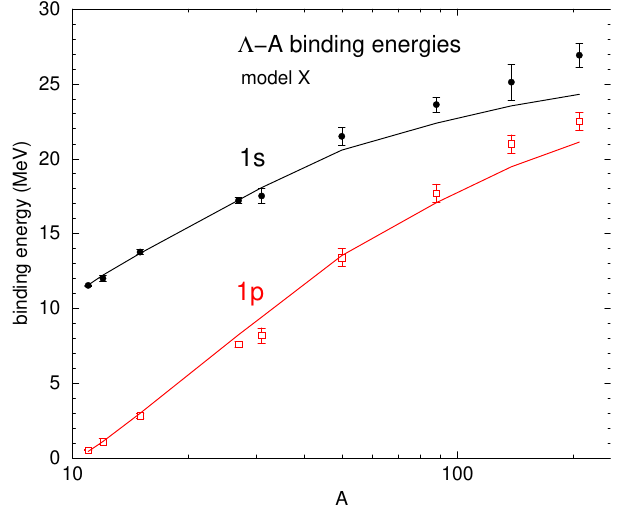
Figure 3. B 1 s , 1 p Λ ( A ) values from model X compared with data. Continuous lines connect calculated